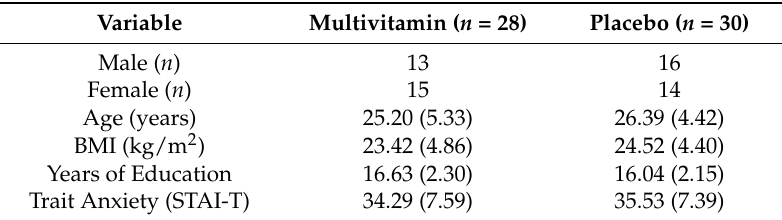
Table 2. Demographic information for study participants (means (SD)). STAI, State-Trait Anxiety